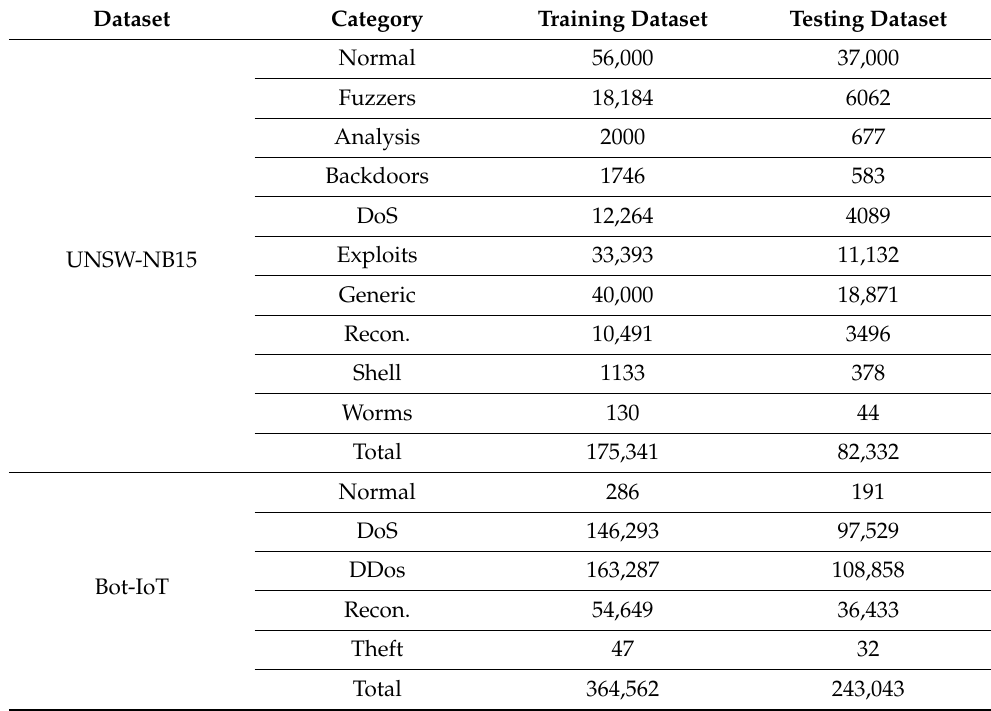
Table 1. Summary of the UNSW-NB15 [64] and Bot-IoT [65] datasets. Reprinted with permission from Ref. [52]. Copyright 2021 IEEE.